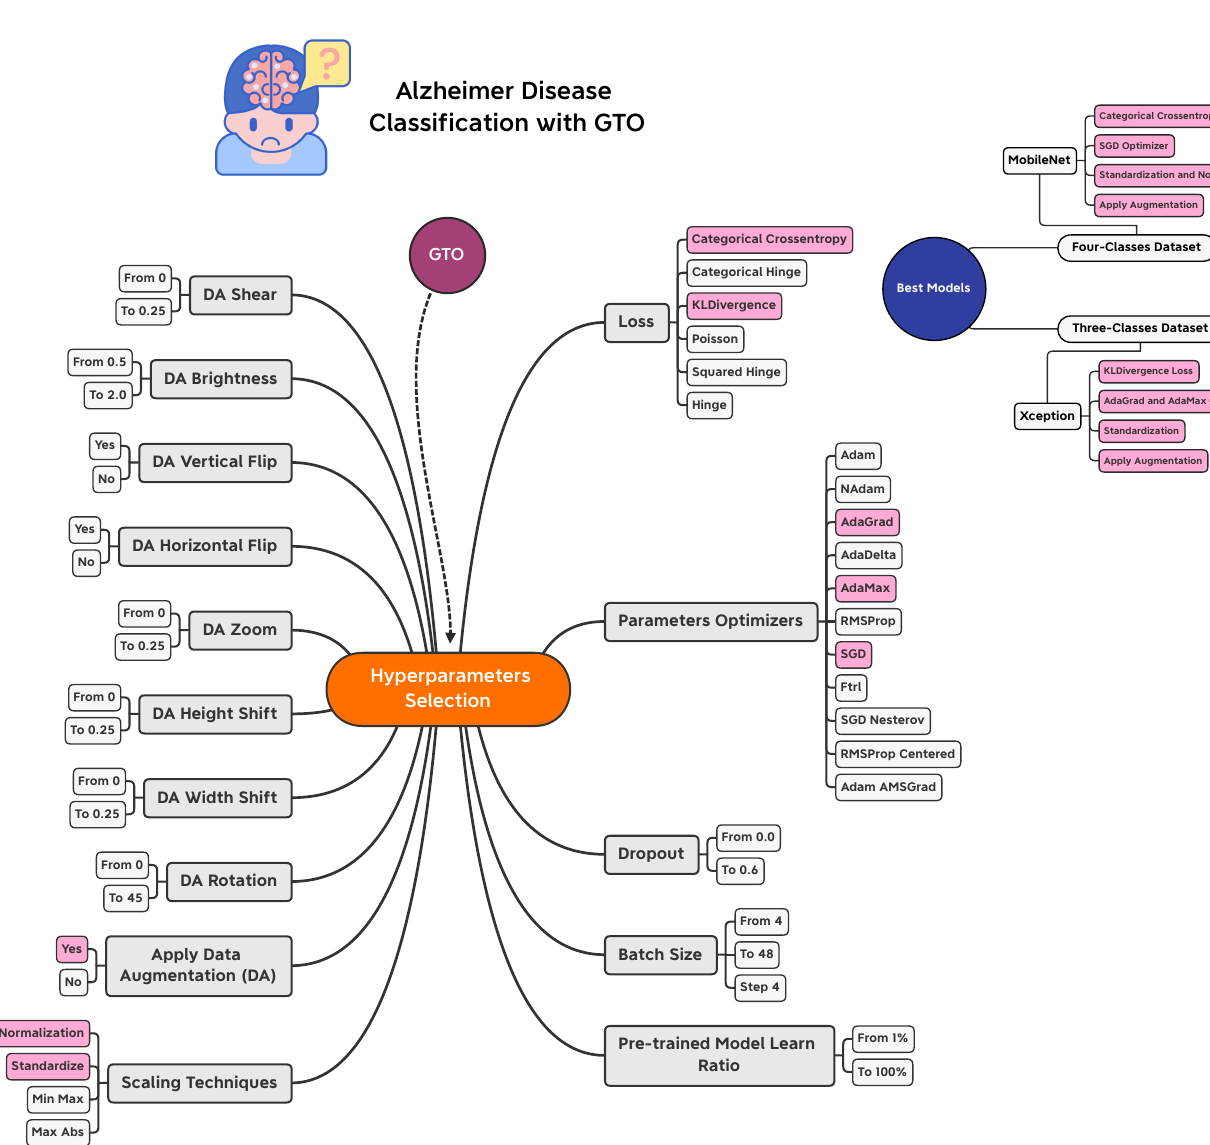
Figure 12. Graphical summary of the performed work in the current study concerning the hyperpa- rameters selection